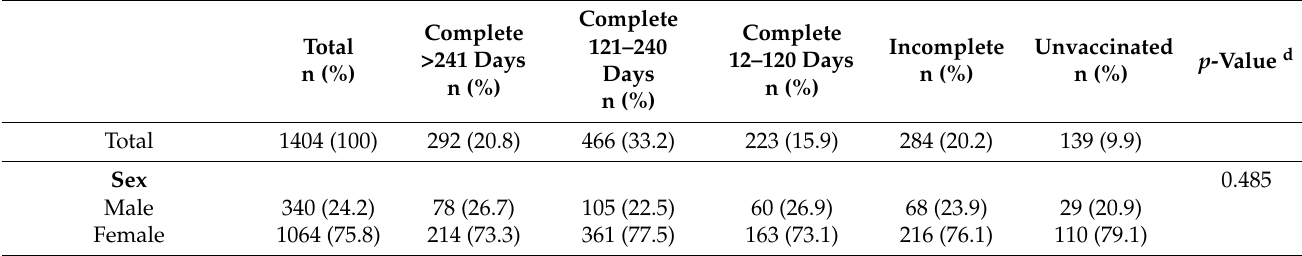
Table 1. Characteristics of the health care workers included in this study according to the vaccination regimen they received (n =